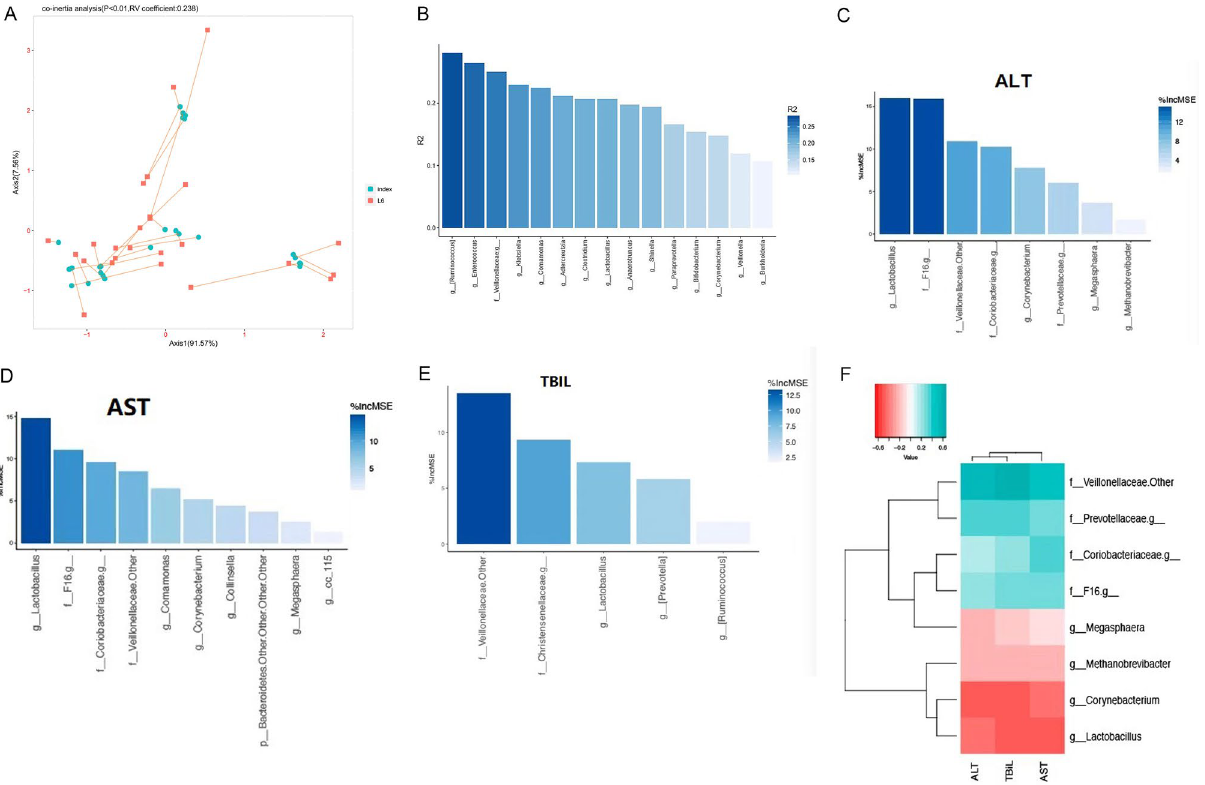
Figure 4. Covariant relationship of bacteria with clinical indicators. ( A ) Co-inertia analysis. ( B – E ) Adnois analysis. ( F ) Random forest